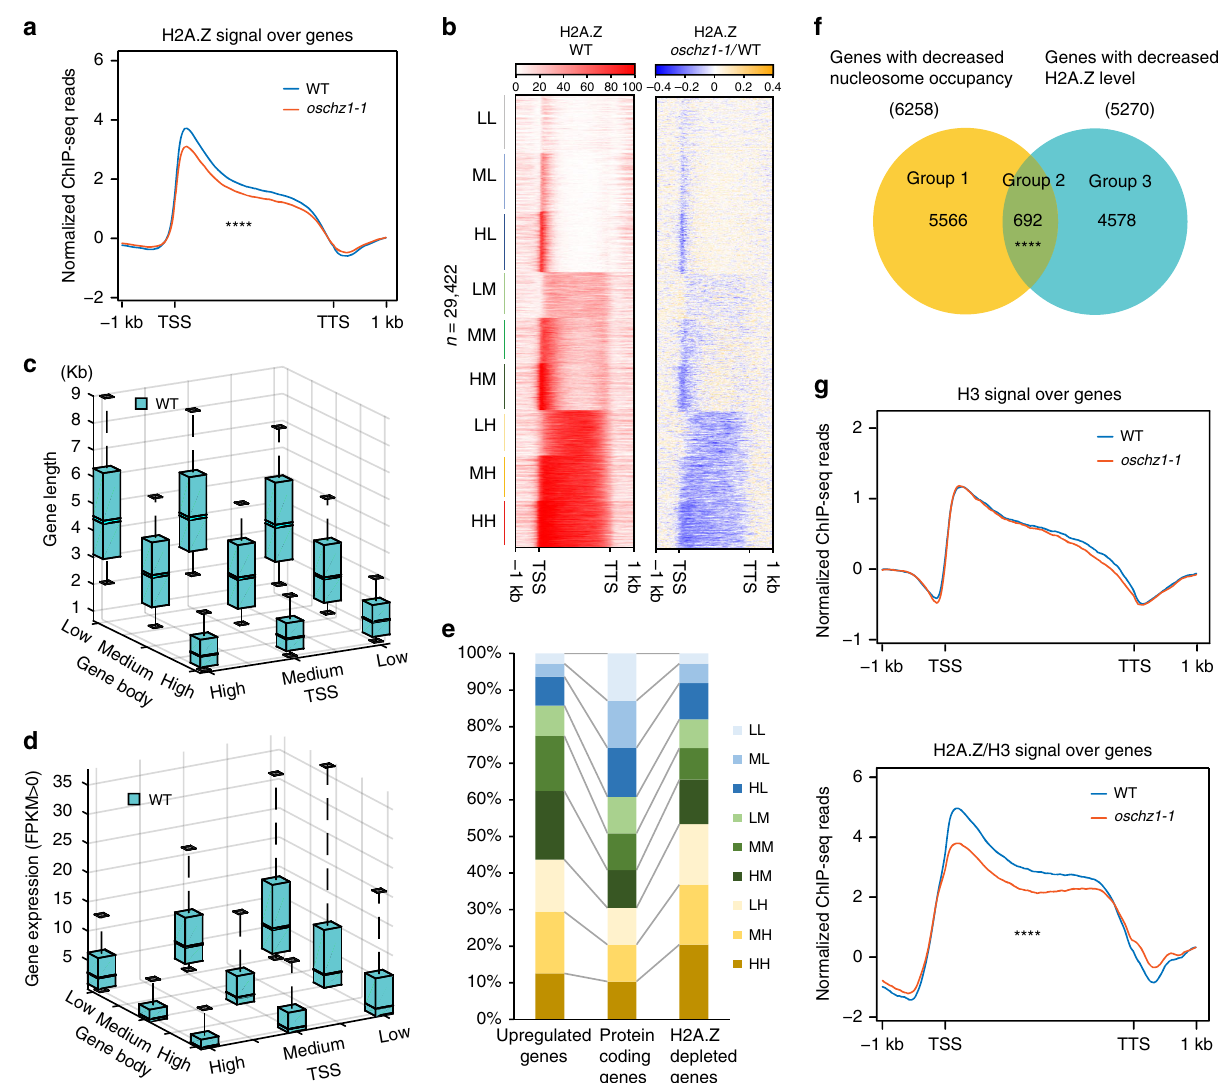
Fig. 7 Impact of the OsChz1 loss on H2A.Z enrichment at the genome-wide level. a Genome-wide H2A.Z occupancy pro fi les in wild-type (WT) and oschz1-1 . The plots were generated from 1 kb upstream of the TSS to 1 kb downstream of the TTS of genes analyzed by ChIP-seq. Signal for H2A.Z is a merge from two biological replicates. Statistic signi fi cances were determined by single-end Welch two-sample t -test: **** p = 1.01 × 10 − 5 . b Heatmap showing H2A.Z levels upstream TSS, along gene body and downstream TTS of genes in WT and oschz1-1 . Genes were divided into nine classes according to the levels of H2A.Z in WT at TSS (low, medium, and high) and gene body (low, medium, and high). Shown are corresponding H2A.Z ratio plots for WT and WT over oschz1-1 . c , d Boxplots showing correlation between gene length and H2A.Z levels ( c ), gene expression in FPKM, and H2A.Z levels ( d ) at TSS and within gene body in WT ( n = 29,422 H2A.Z-enrichment genes). Center line indicates the median, upper and lower bounds represent the 75th and the 25th percentile, respectively, whiskers indicate the minimum and the maximum. e Intersection comparisons of H2A.Z-depleted genes (right) and upregulated genes (left) in oschz1-1 with the nine classes of genes characterized by their distribution of H2A.Z in WT (middle). Labels H, M, and L indicate for high, medium, and low levels of H2A.Z at TSS ( fi rst letter) and gene body (second letter), respectively. f Venn diagram for the overlap of genes with reduced nucleosome occupancy and genes with decreased H2A.Z in oschz1-1 . Signi fi cance level of the intersection was examined by single-end Fisher ’ s exact test: **** p = 2.01 × 10 − 6 . g Genome-wide H3 occupancy pro fi les in wild-type (WT) and oschz1-1 (top graph) and that of H2A.Z normalized with H3 (bottom graph). The pro fi les were generated from 1 kb upstream of TSS to 1 kb downstream of TTS along genes. Statistic signi fi cances were determined by